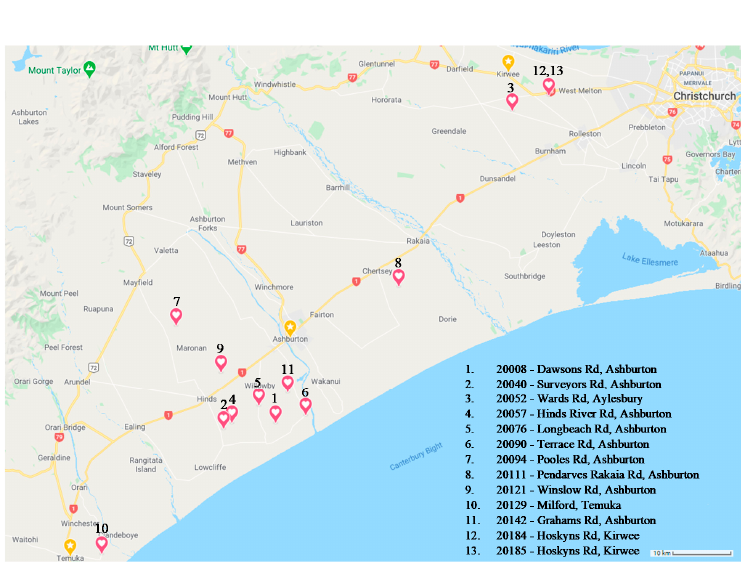
Figure 1. Approximate biogeographical locations of each Biogeography Seed accession.